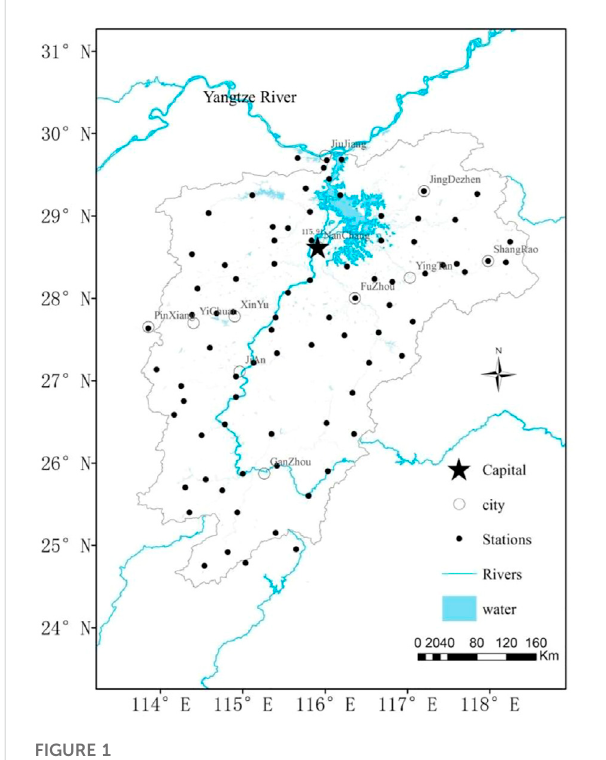
Location of the main cities and distribution of meteorological stations in the Poyang Lake Basin,